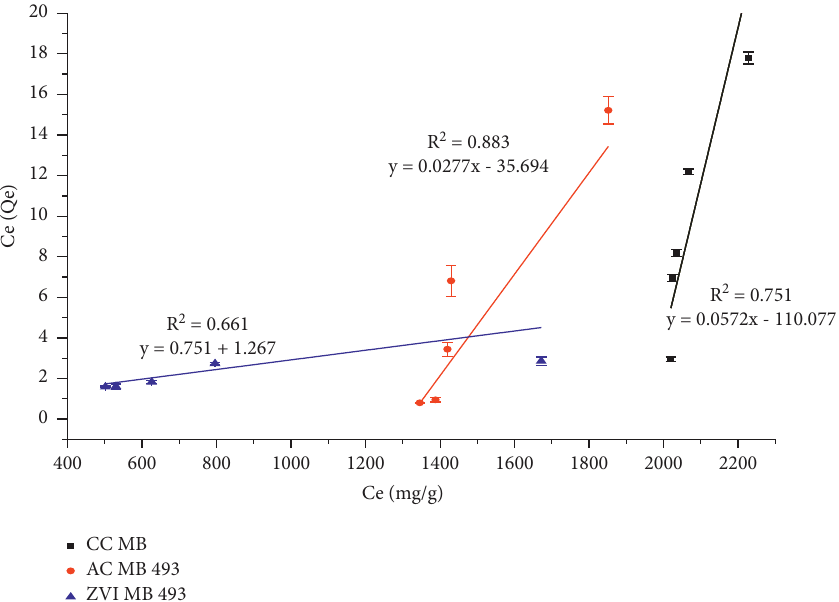
Figure 7: Langmuir adsorption isotherm for removal of β -carotene onto CC MB, AC MB 493, and ZVI MB 493 at 95 ° C. Table 2: Freundlich, Langmuir, and Temkin constants for the adsorption of β -carotene onto CC MB, AC MB 493, and ZVI MB 493 at 75 ° C and 95 ° C.